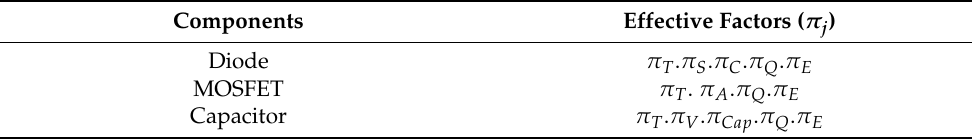
Figure 11. MOSFET and diode power loss models in the on-state.